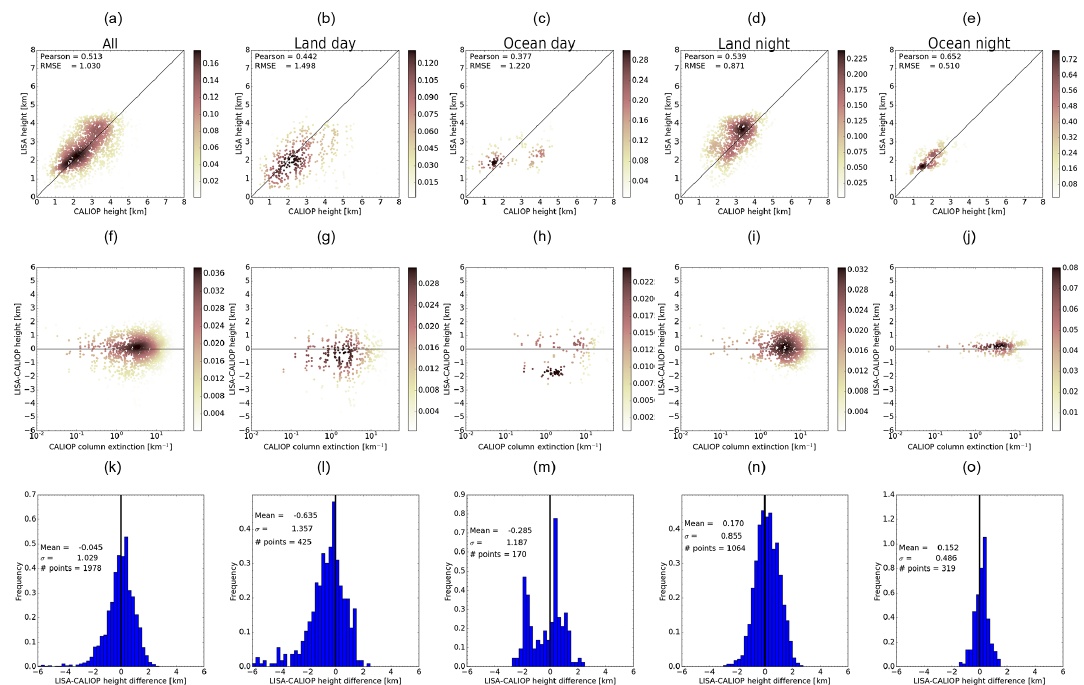
Figure A4. Similar to Fig. A1 but for the LISA